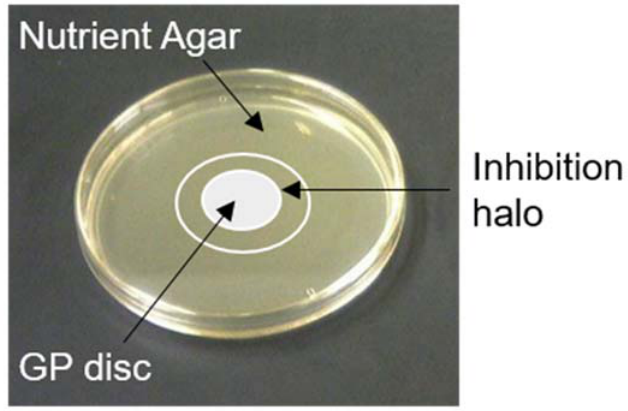
Figure 3. Assembly of the nutrient agar method.